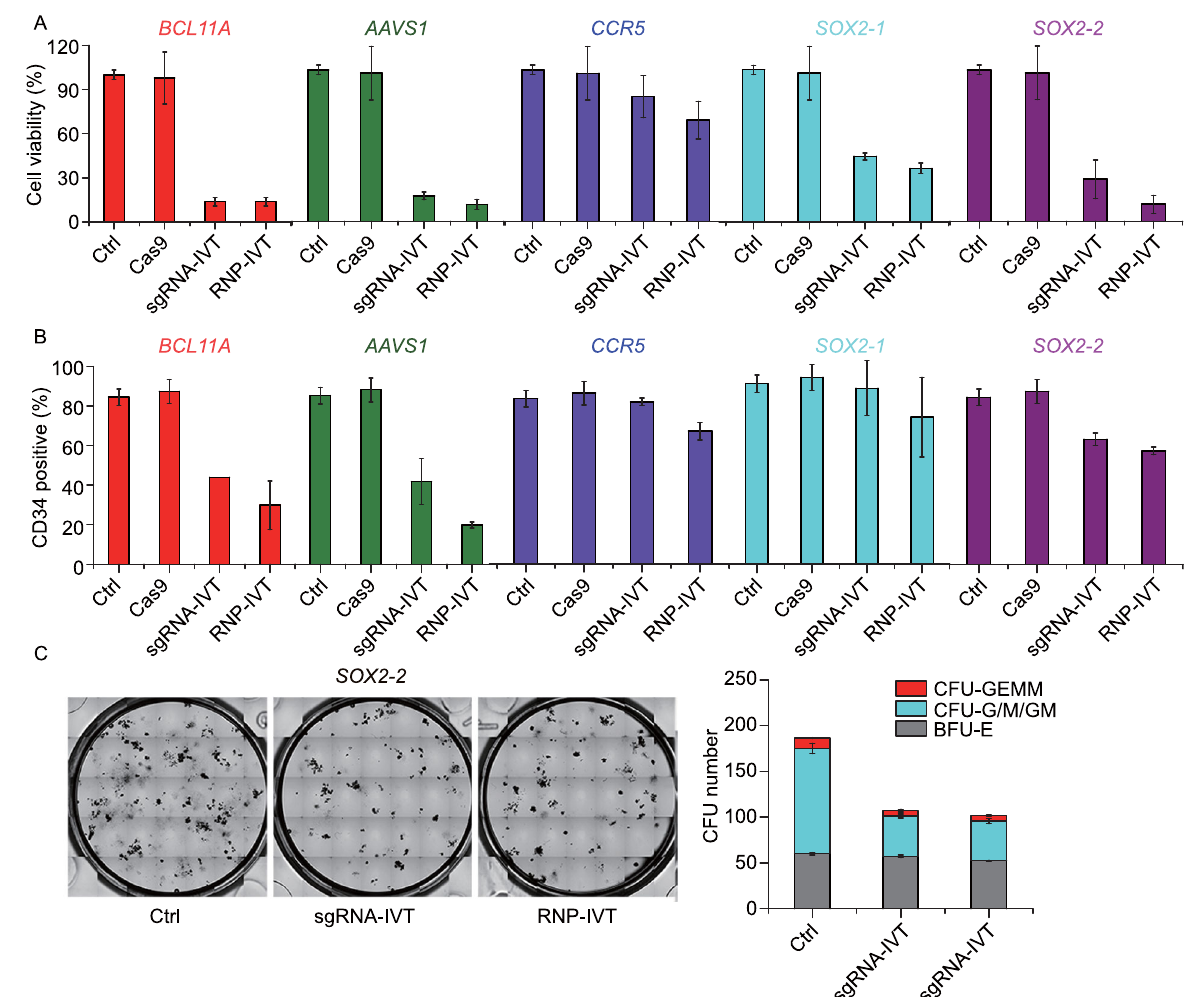
Figure 1. IVT sgRNA induced the production of IFN- α , which lead to severe cell death and stemness reduction in human CD34 + HSPCs . (A – C) Cell viability (A), CD34 expression (B) and colony forming units (C) of human primary HSPCs electroporated with indicated samples. Cell viabilities and CD34 expression were measured 48 h post electroporation by cell counting and FACS respectively. For colony forming unit (CFU) assay, same number of viable cells were seeded 48 h post electroporation, the colony number and lineage differentiation were counted and analyzed two weeks later. In (A), (B), (C) experiments were performed in HSPCs from two donors. Error bars represent SD for two biological replicates. (D) Type I IFN production in HSPCs after electroporation. RNPs targeting indicated sites were delivered into HSPCs. The IFN concentration in medium supernatant were measured 24 h post electroporation by ELISA, respectively (mean ± SD, n = 3). (E and F) The cell viability (mean ± SD, n = 3) (E) and CD34 expression (F) of HSPCs after co-culture with IFN in different